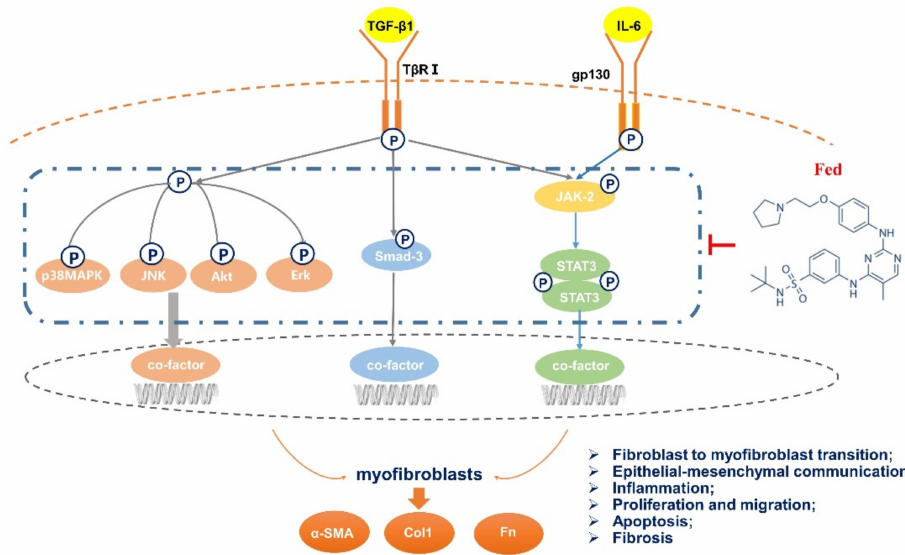
Figure 10. Mechanisms of the anti-pulmonary-fibrosis effect of fedratinib. Fedratinib improves bleomycin-induced pulmonary fibrosis in mice by inhibiting aberrant mesenchymal marker expression of AECs, fibroblast-to-myofibroblast transition, inflammation and apoptosis by targeting the JAK2 receptor and TGF- β 1 downstream Smad3 and MAPK signaling